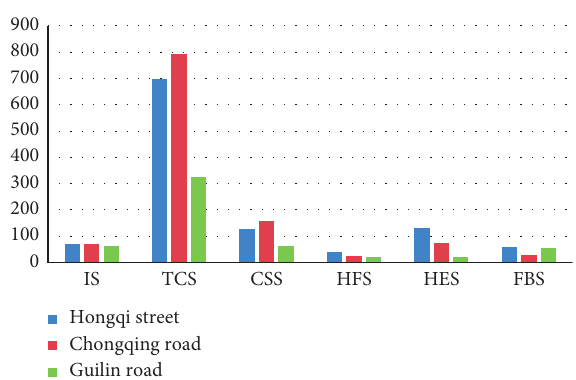
Figure 2: The quantities of retail stores in three main commercial